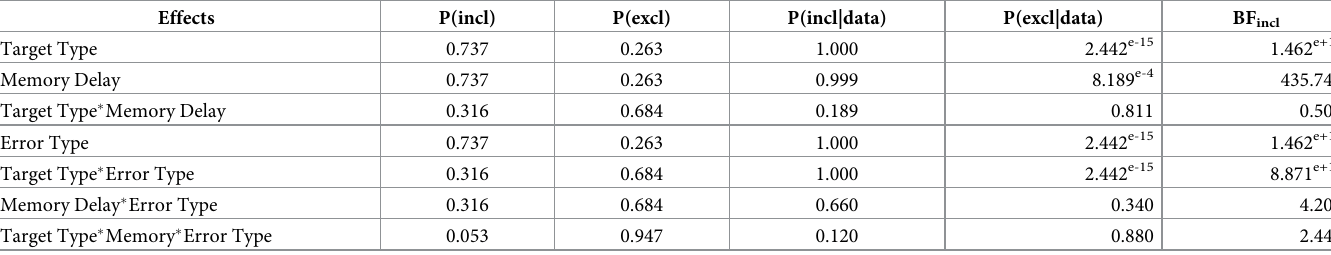
Table 1. Error rates